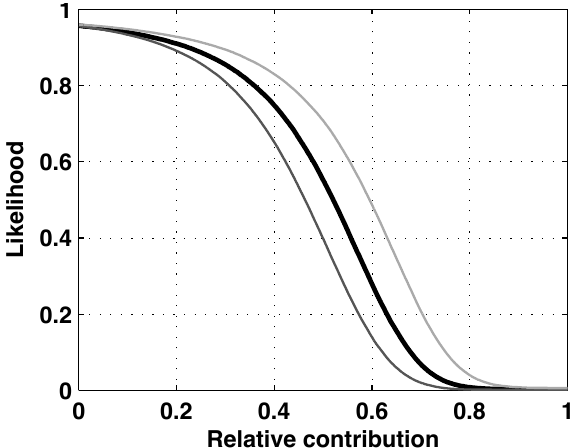
Figure 2. The thick black curve is the likelihood that the barystatic contribution to ENSO-related GMSL changes will exceed a certain fraction of the sum of barystatic and steric terms based on Monte Carlo runs, where the steric term is evaluated based on the average of the SIO and IPRC gridded data products. The thin dark gray (light gray) curve is that same likelihood but with the steric term assessed using only the SIO (IPRC)